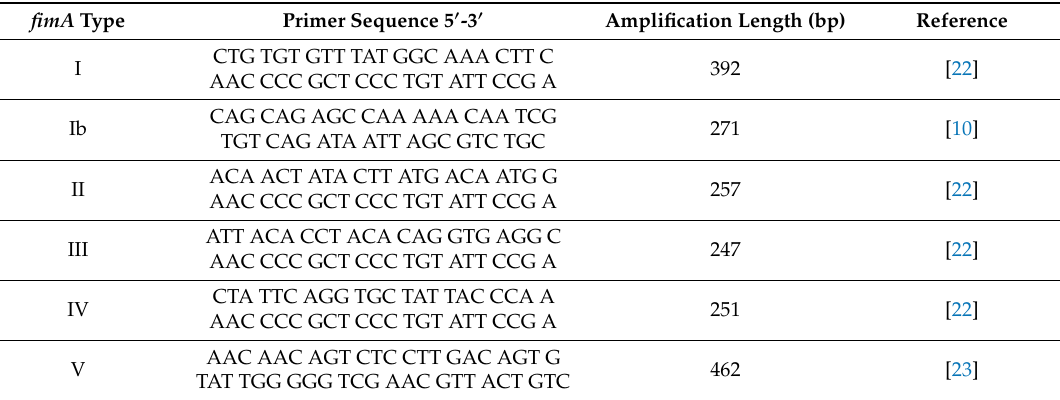
Table 1. PCR primers used in the